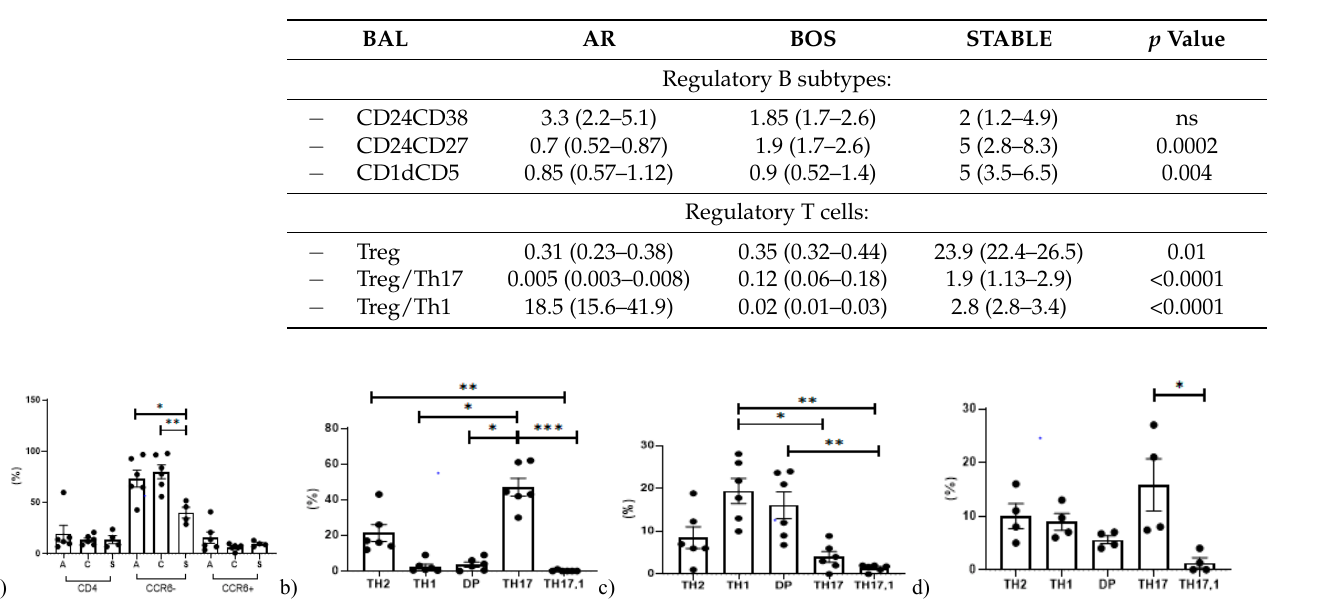
Figure 6. ( a ) CD4 + , CCR6 − and CCR6 + cells differed in percentages between the Stable group and the other two groups. Fig. 6. a) CD4+. CCR6- and CCR6+ cells differed in percentages between the stable group and the other two groups. Data represent individual Data represent individual values on BAL, mean (center bar) ± SEM (upper and lower bars). If not indicated, p value is not significant. * p < 0.05, ** p < 0.01, *** p < 0.001. Th cells distribution on BAL of Acute Rejection group ( b ), BOS ( c ) and Stable values on BAL. mean (centre bar) ± SEM (upper and lower bars). If not indicated. p value is not significant. *p<0.05. **p<0.01. ***p<0.001. Th patients ( d ). cells distribution on BAL of Acute Rejection group (b). BOS (c) and stable patients (d).